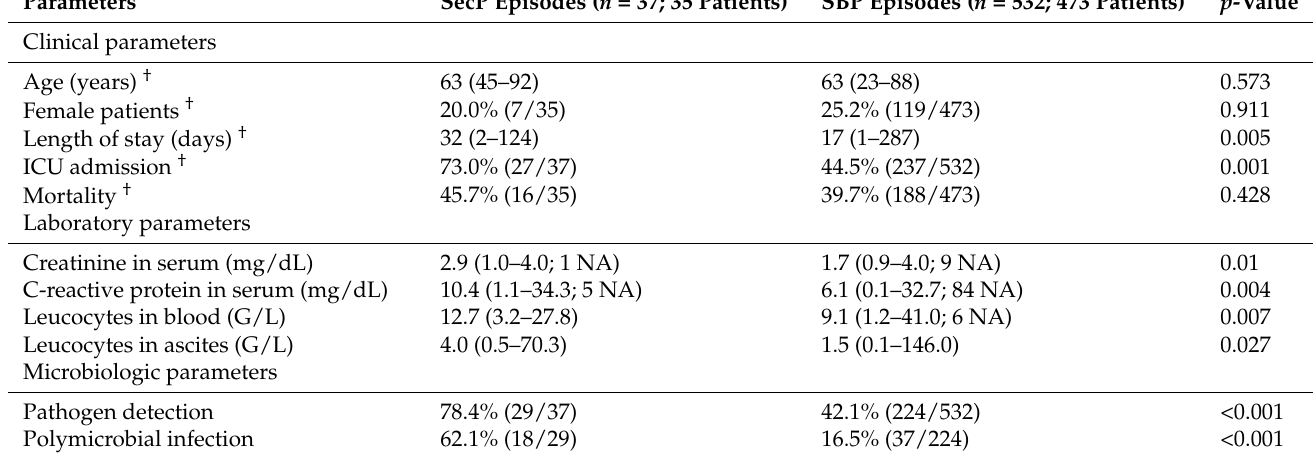
Table 1. Comparison of SecP and SBP episodes. Parameters are displayed as relative frequency in % (absolute frequency) or median (range). Parameters marked with † were not considered for the random forest and LASSO regression model. All parameters are based on episodes apart from sex and mortality, which are based on patients. The blood parameter creatinine was adapted to dialysis as previously described for MELD score calculations. ICU, intensive care unit; SecP, secondary peritonitis; SBP, spontaneous bacterial peritonitis; NA, not